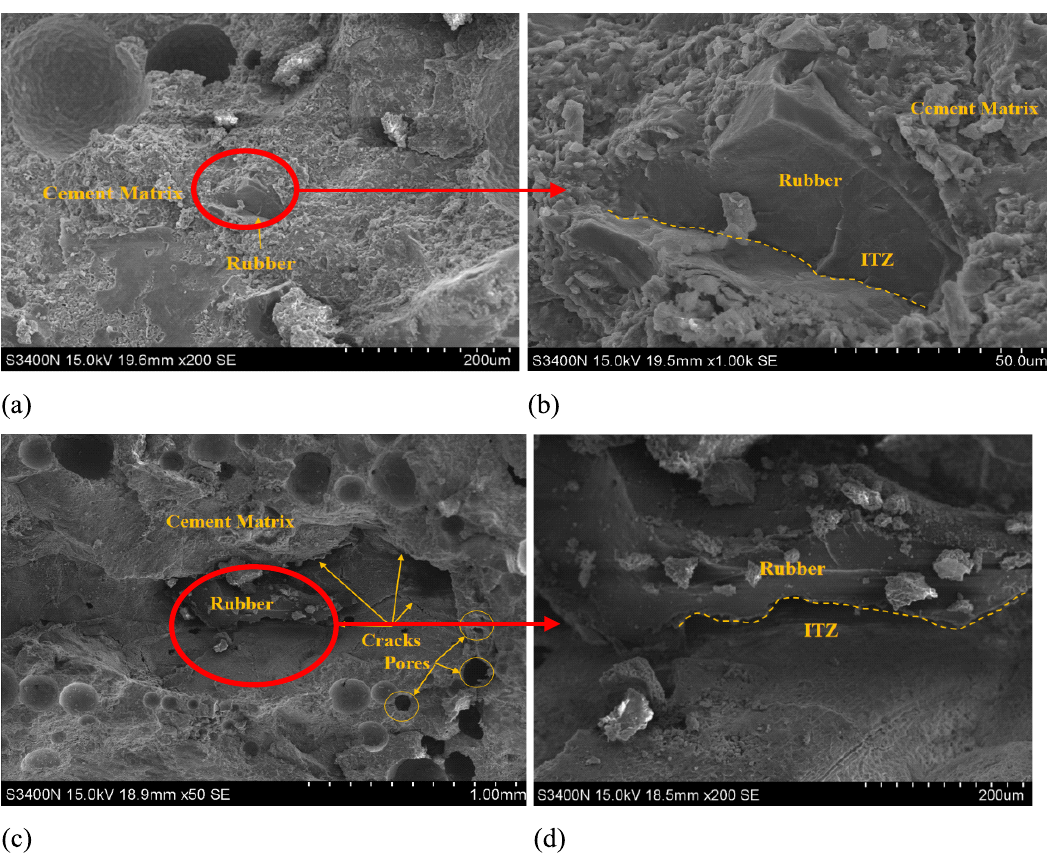
Figure 21: Comparison of microstructures of RRAC with and without rubber modi fi cation treatment: ( a and b ) with treatment and ( c and d ) without